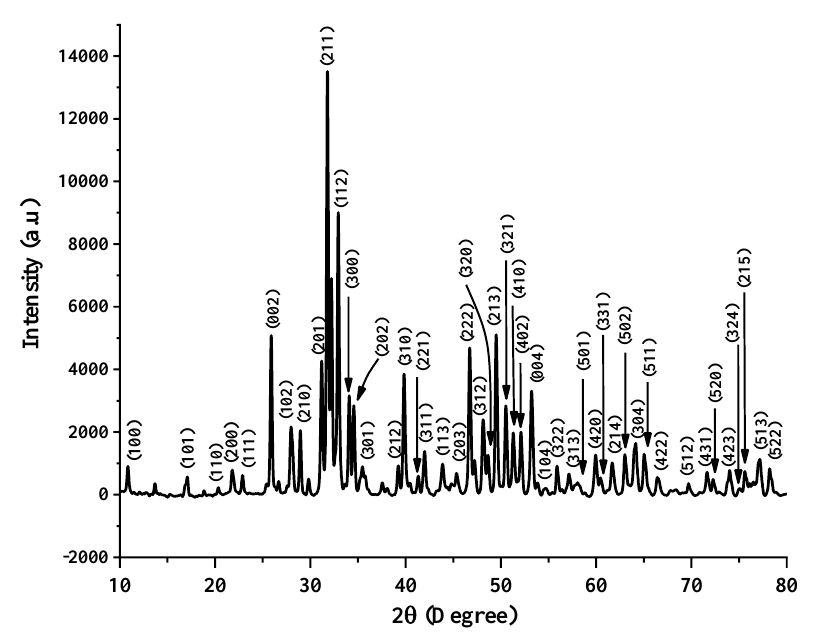
Coatings 2023 , 13 , x FOR PEER REVIEW Figure 2. XRD pattern of FsHA powder peaks labelled with Miller indices. Figure 2. XRD pattern of FsHA powder peaks labelled with Miller indices.